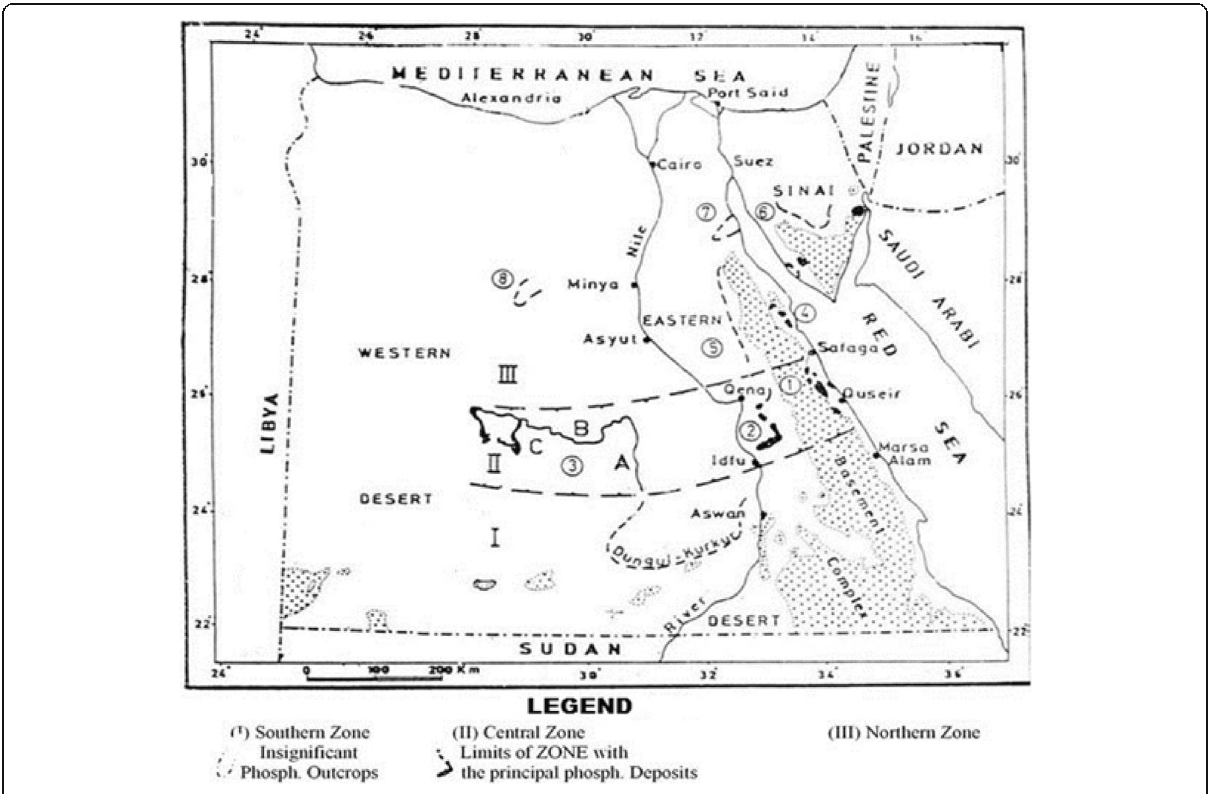
Fig. 1 Distribution of phosphate deposits in